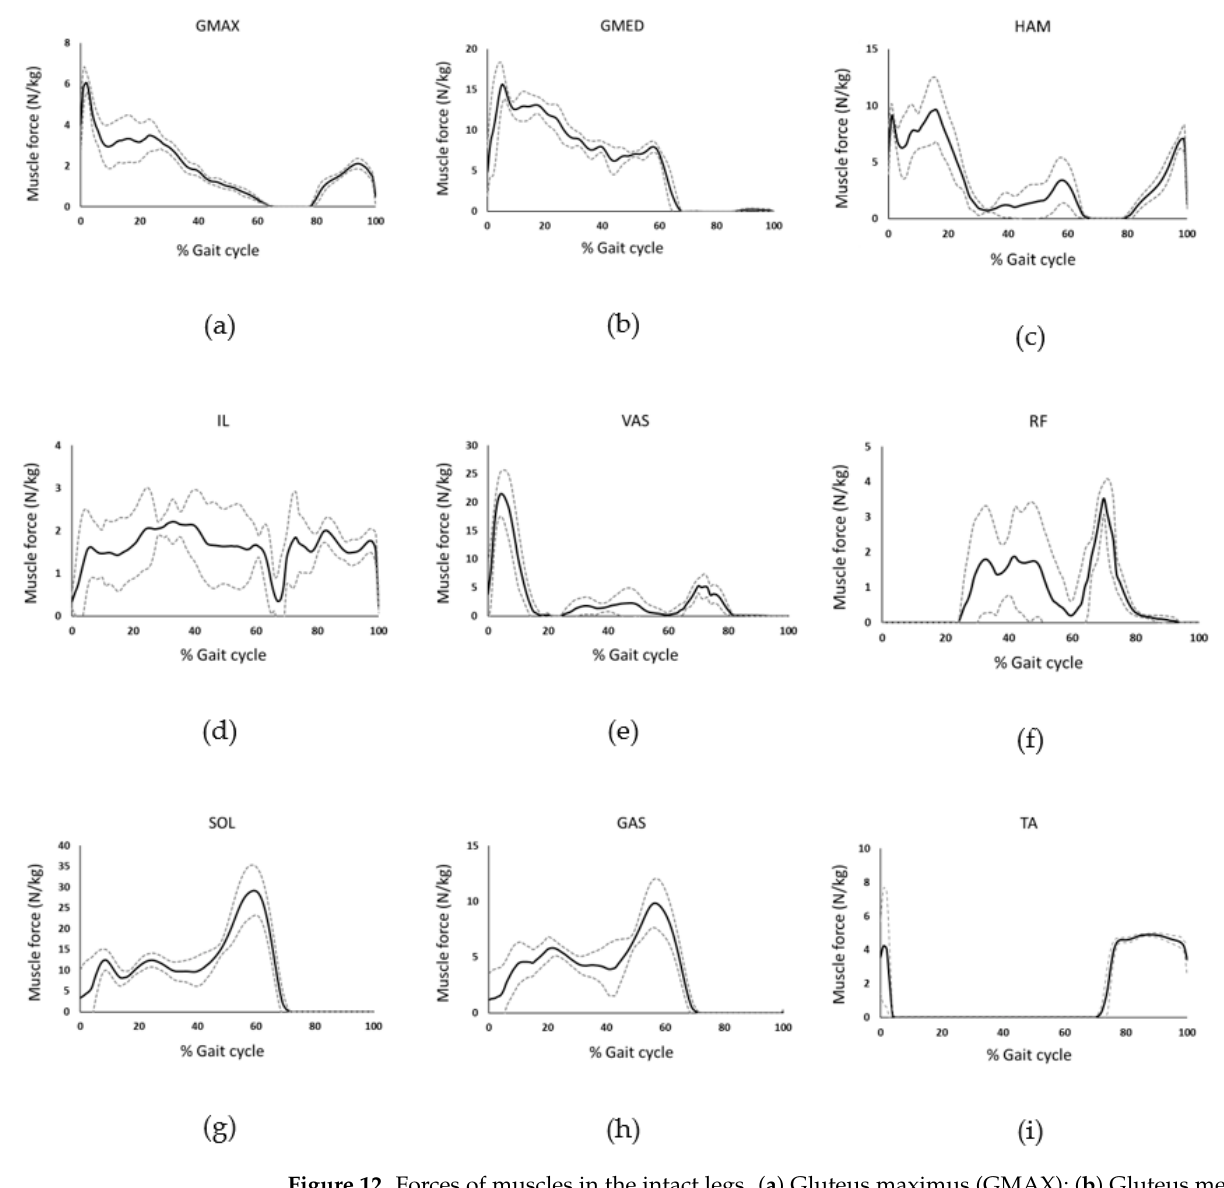
Figure 12. Forces of muscles in the intact legs. ( a ) Gluteus maximus (GMAX); ( b ) Gluteus medius (GMED); ( c ) Biceps femoris, Semitendinosus, Semimembraneous (HAM); ( d ) Iliacus, Psoas (IL); ( e ) Vastus lateralis, Vastus medialis, Vastus intermedius (VAS); ( f ) Rectus femoris (RF); ( g ) Soleus (SOL); ( h ) Gastrocnemius (GAS); ( i ) Tibialis anterior (TA). The solid and dashed lines indicate the mean values and standard deviations, respectively.